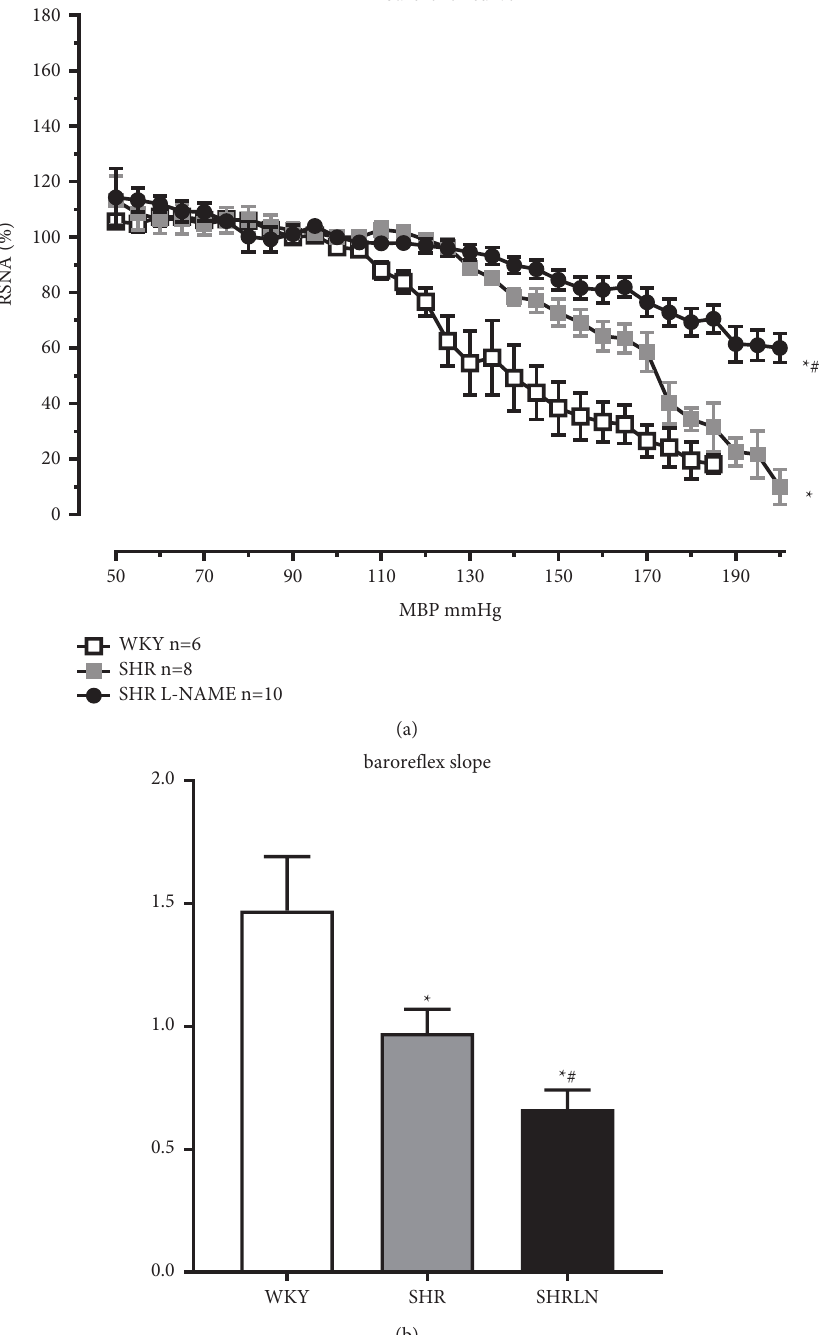
Figure 2: (a) The baroreflex curve in the 3 groups of rats, normotensive WKY and hypertensive SHR and SHRLN. The curves are significantly different between groups and the values differ significantly in function of MBP (two-way ANOVA, P < 0 . 05 for both pressure and groups). (b) The slope of the descending part of the curve (increase in MBP), unpaired Student ’ s t -test. ∗ P < 0 . 05 versus WKY. # P < 0 . 05 SHRLN versus